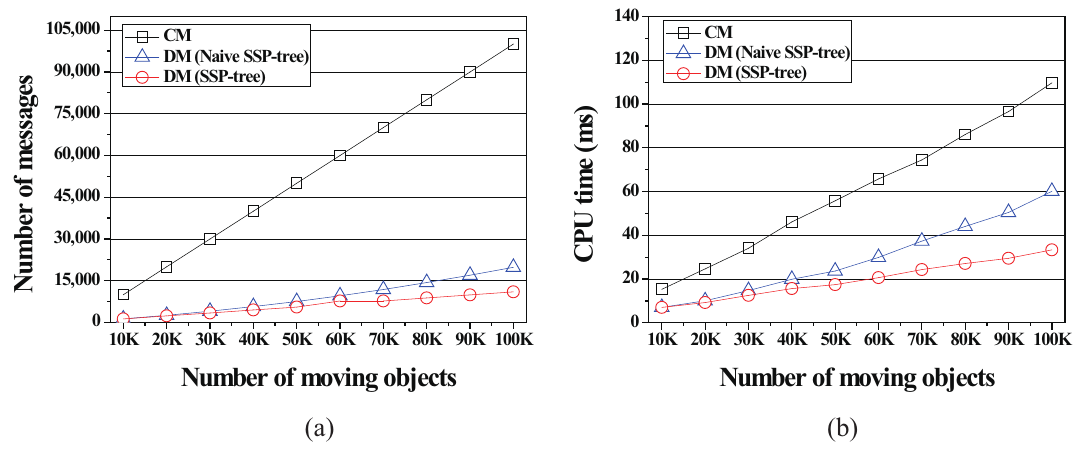
Figure 9. Effect of the number of moving objects on the communication cost and the server computation cost. ( a ) Total number of messages vs. the number of moving objects; ( b ) The amount of CPU-time vs. the number of moving